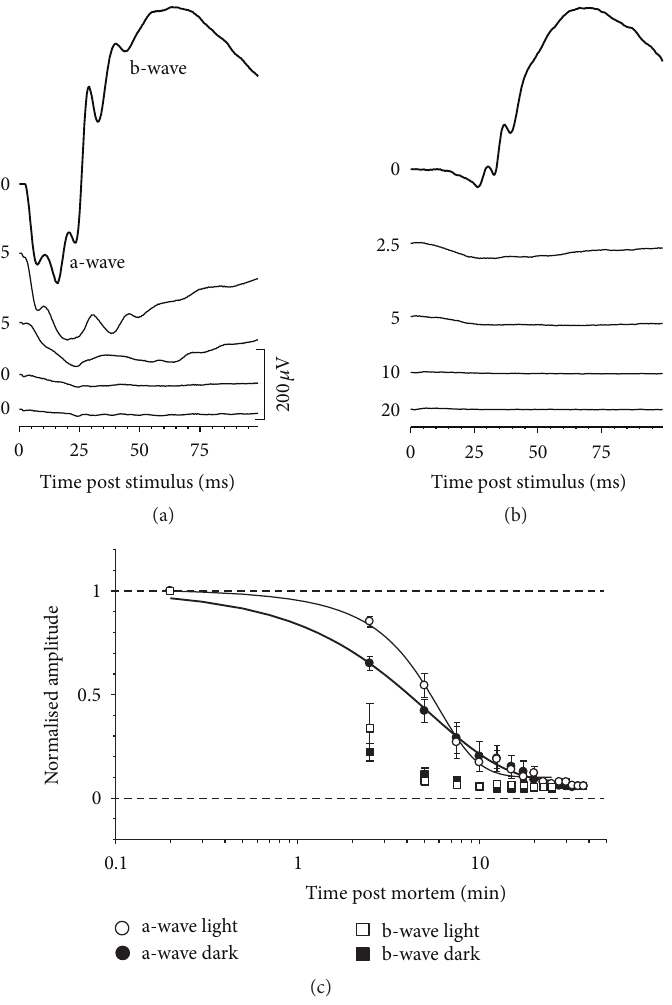
F 2: Light adapting the retina results in relatively slower decay of a-wave amplitudes at 2.5 and 5 minutes following ischemic insult. ERG loss under dark- (a) and light-adapted conditions (b). Group data are shown in (c). Reprinted from [24] with permission. e Association for Research in Vision and Ophthalmology remains the copyright